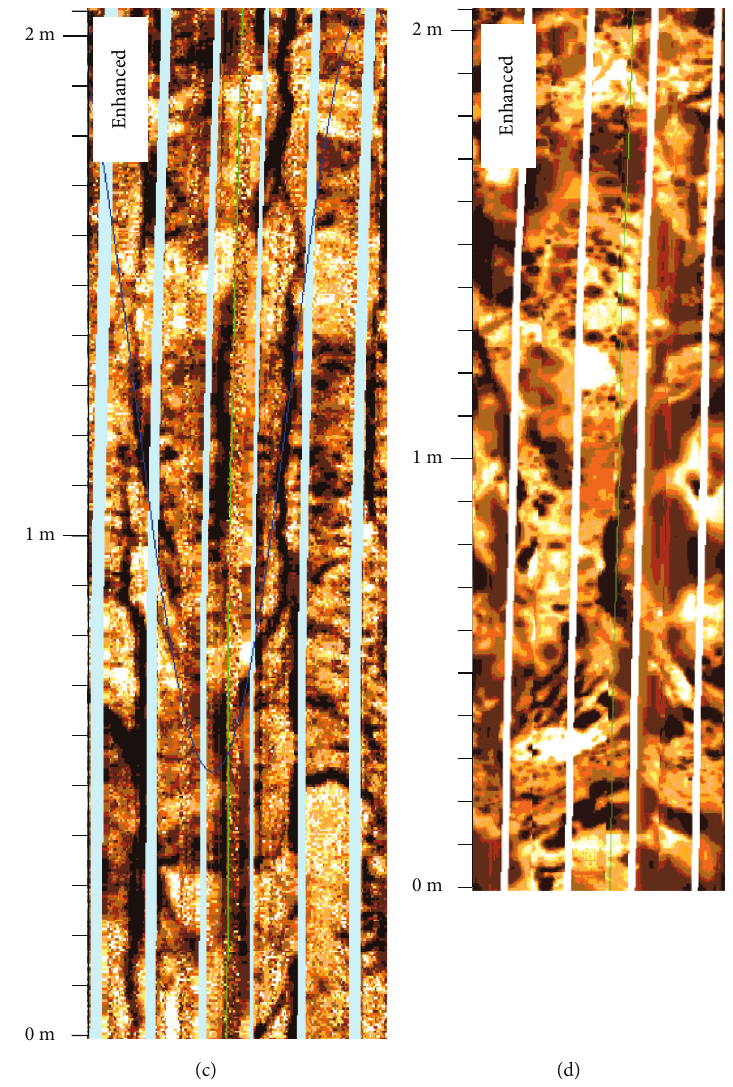
Figure 5: FMI interpretation of carbonate reservoir